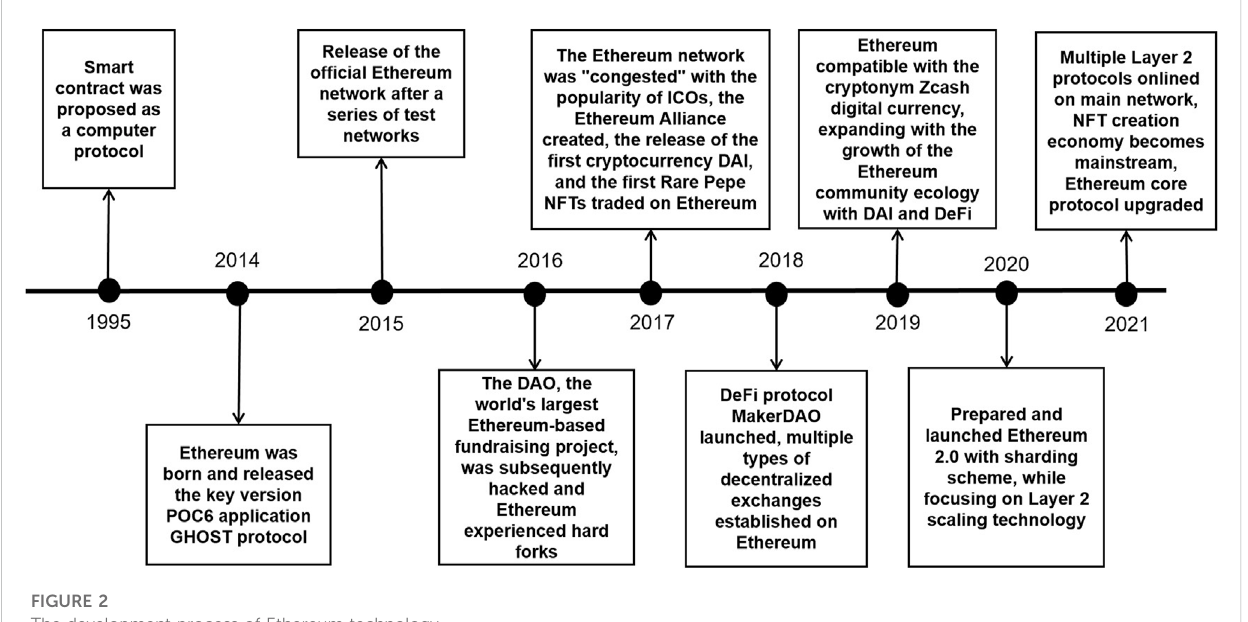
FIGURE 2 The development process of Ethereum